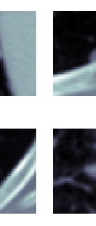
Figure 31. SFMPF model based on LOG image—missed nodules (FN).